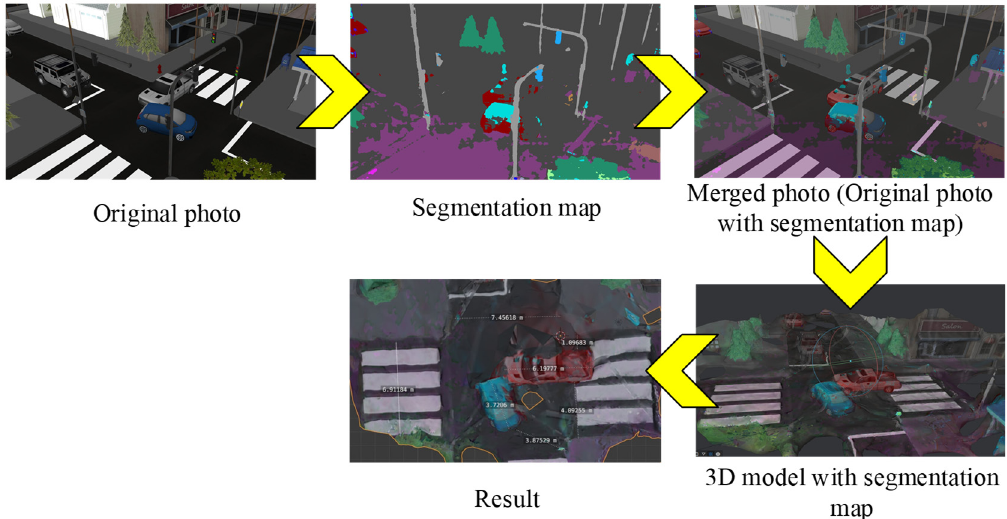
All intermediate results obtained during the processing of a set of images of an acci- dent scene are shown in Figure 13.